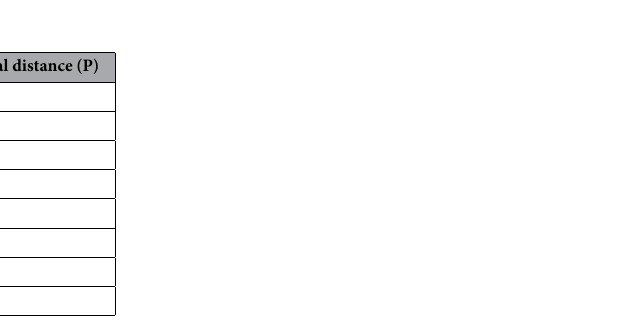
Table 3. Results of identification success analysis for the criteria: best match, best close match and all species barcodes.